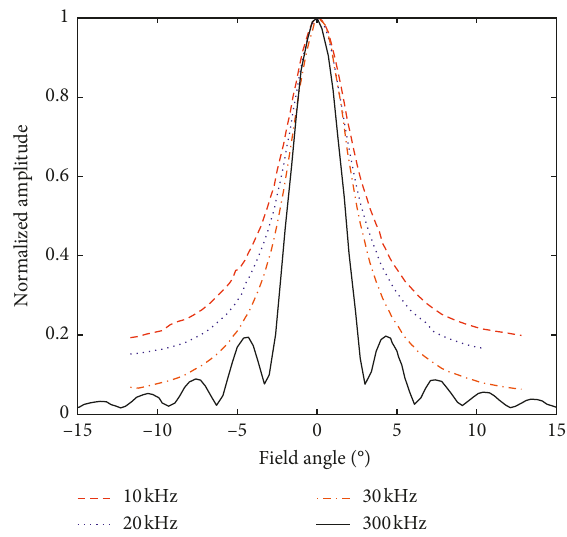
Figure 1: Sketch of measurement